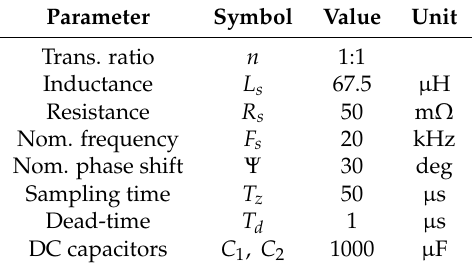
Table A1. System